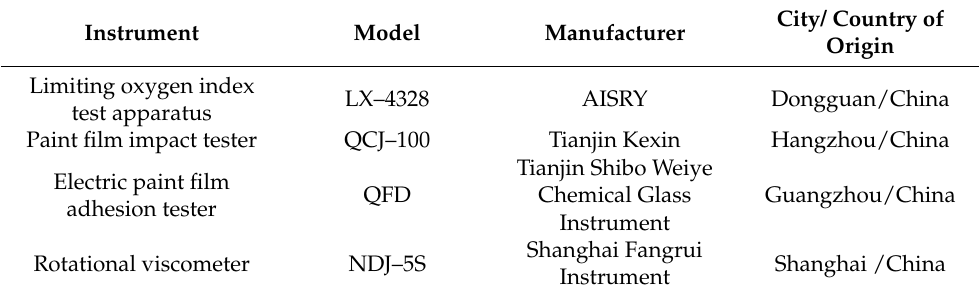
Table 1. Models of the instruments used in the